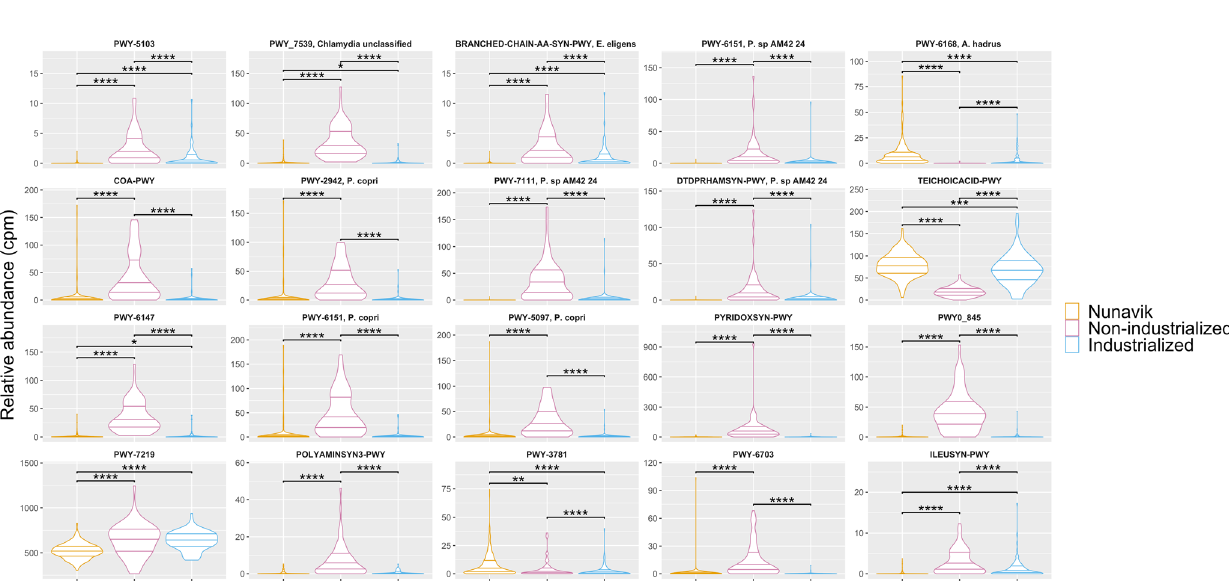
Fig. 7 Top 20 Random Forest identi fi ed pathways that discriminate between Nunavik, non-industrialized and industrialized gut microbiome. Violin Plots represent the relative abundance (copies per million) of RF identi fi ed pathways distinguishing between Nunavik and comparison groups microbiome (in decreasing Gini importance order). (* p -value ≤ 0.05, ** p -value ≤ 0.01, *** p -value ≤ 0.001, **** p -value ≤